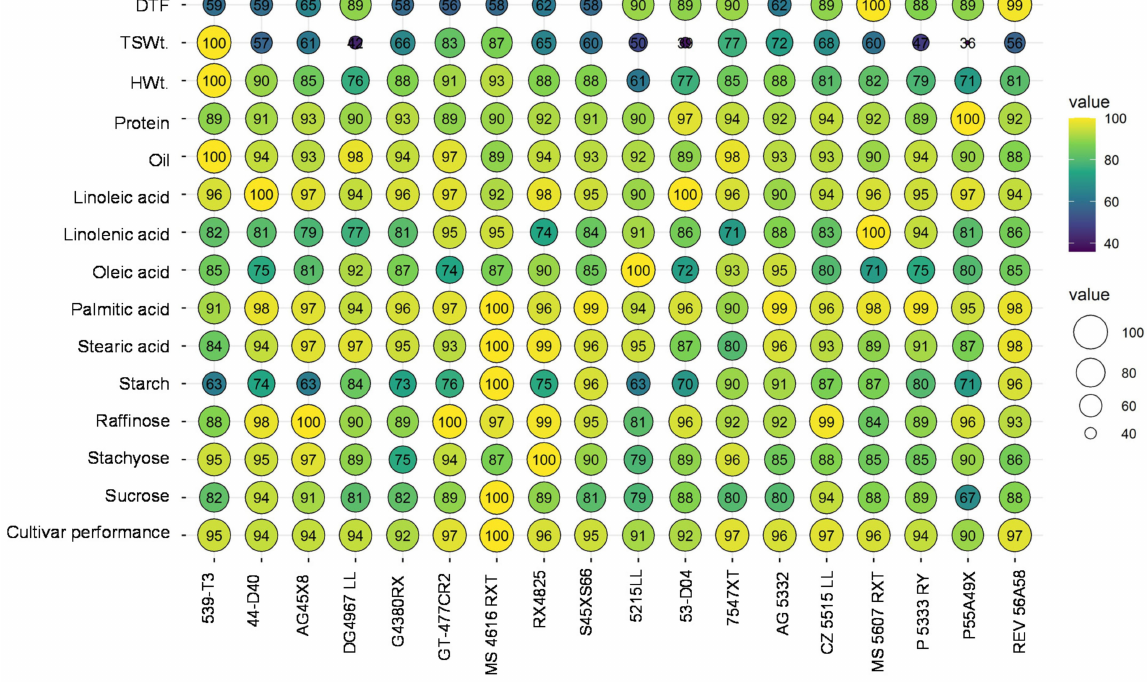
Figure 5. Bubble plot of the cultivar’s relative values in percentage, calculated from the yield and seed quality parameters of 18 soybean cultivars grown under non-stressed conditions. The size and values of the bubble designated to each cultivar indicate the level of performance for a given parameter or overall cultivar performance (higher value signifies better performance and vice